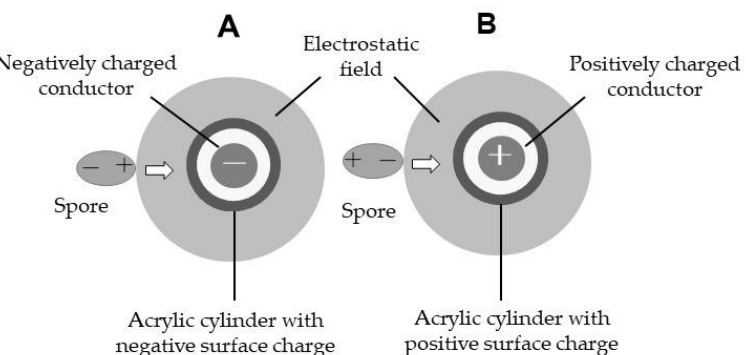
Figure 3. Schematic representation of attraction of spores entering the electrostatic field of an insulator: ( A ) negatively or ( B ) positively electrified by dielectrophoresis.